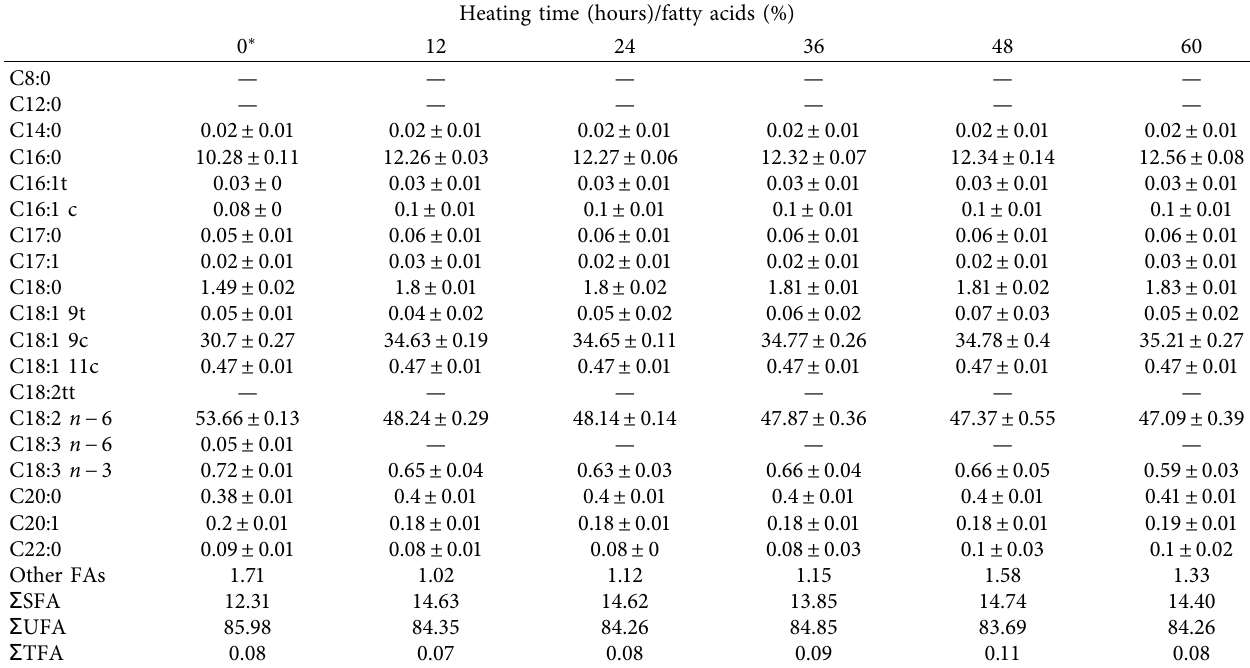
Table 3: Variation of fatty acids of corn oil under 150 ° C heating temperature at different heating times. Heating time (hours)/fatty acids (%)